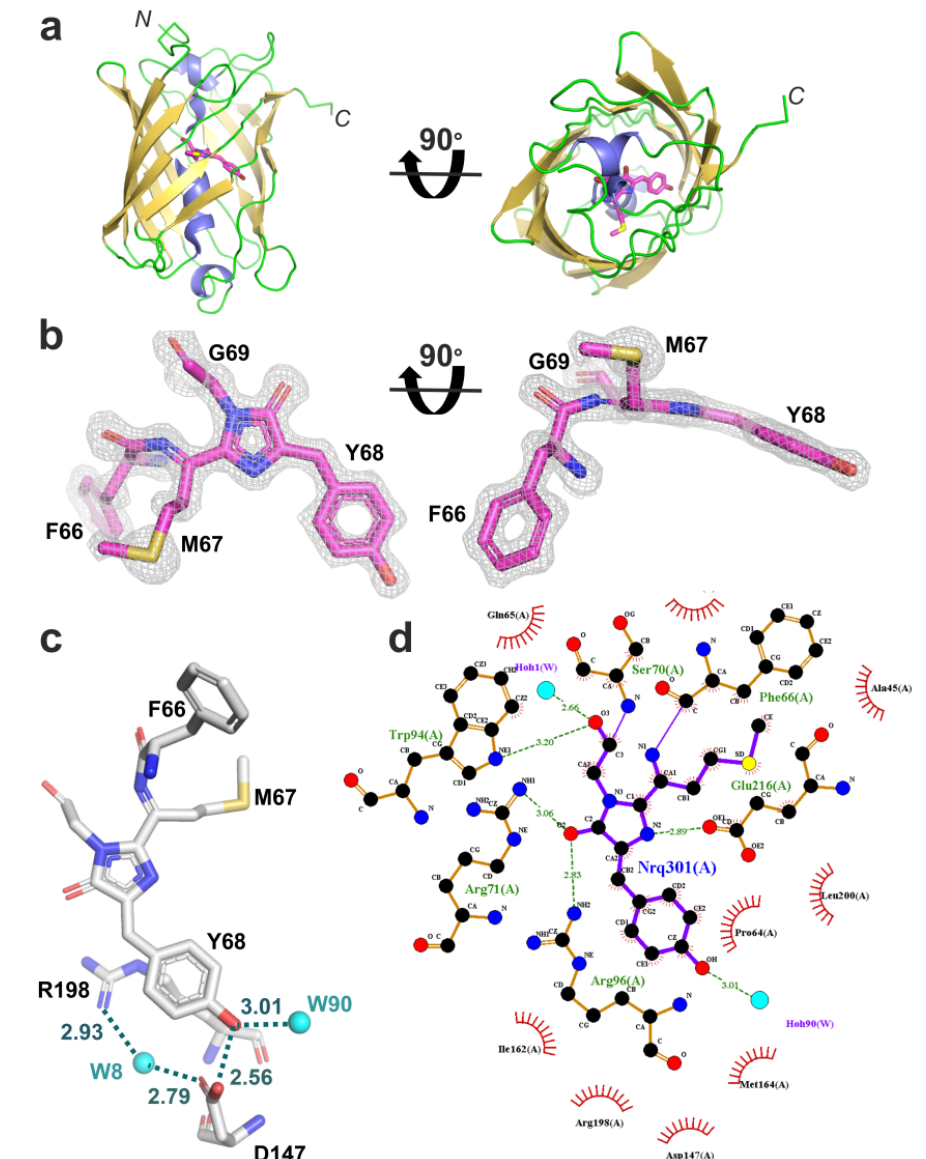
Figure 3. X-ray structure of the LSSmScarlet2 protein. ( a ) Cartoon representation of the overall LSSmScarlet structure. β -Sheets, α -helixes, and unstructured regions are shown in yellow, blue, and green, respectively. Chromophore carbon atoms are colored in magenta. The orientation of the panel on the right is rotated 90 ◦ around the horizontal axis with respect to that on the left. ( b ) 2Fobs-Fcalc electron density map is shown for the chromophore of the LSSmScarlet2 protein. The electron density map is shown as a gray mesh and contoured at the 1.5 σ level. The orientation of the chromophore on the right is rotated 90 ◦ around the horizontal axis with respect to that on the left. ( c ) Hydrogen bond network around the phenolic hydroxyl group of the LSSmScarlet2 chromophore. ( d ) Immediate environment of the LSSmScarlet2 chromophore.